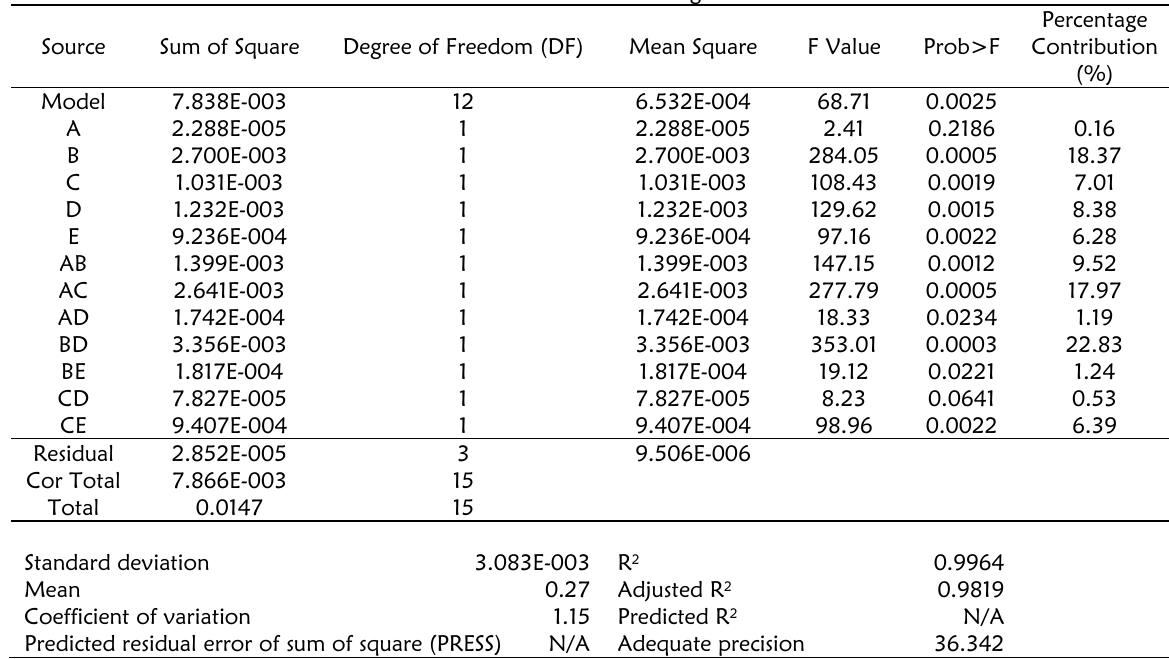
Table 6: ANOVA for average